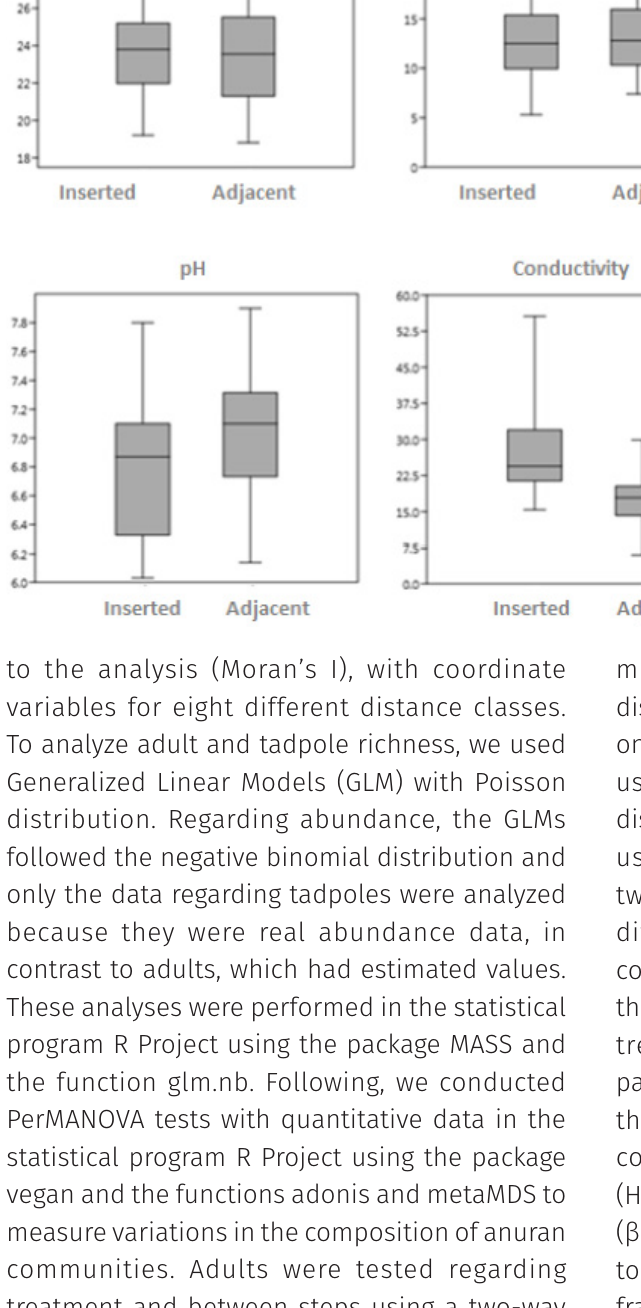
Figure 2. Physical and chemical parameters of water measured in ponds that are inserted or adjacent to soybean